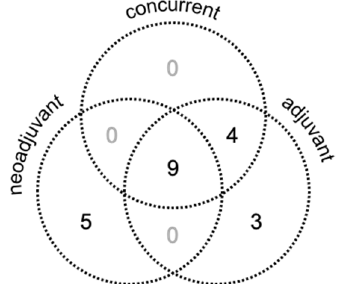
Figure 2. Timing of systemic therapy with RT. Patients in this cohort received a combination of neoadjuvant or adjuvant atezolizumab plus bevacizumab, and/or concurrent atezolizumab